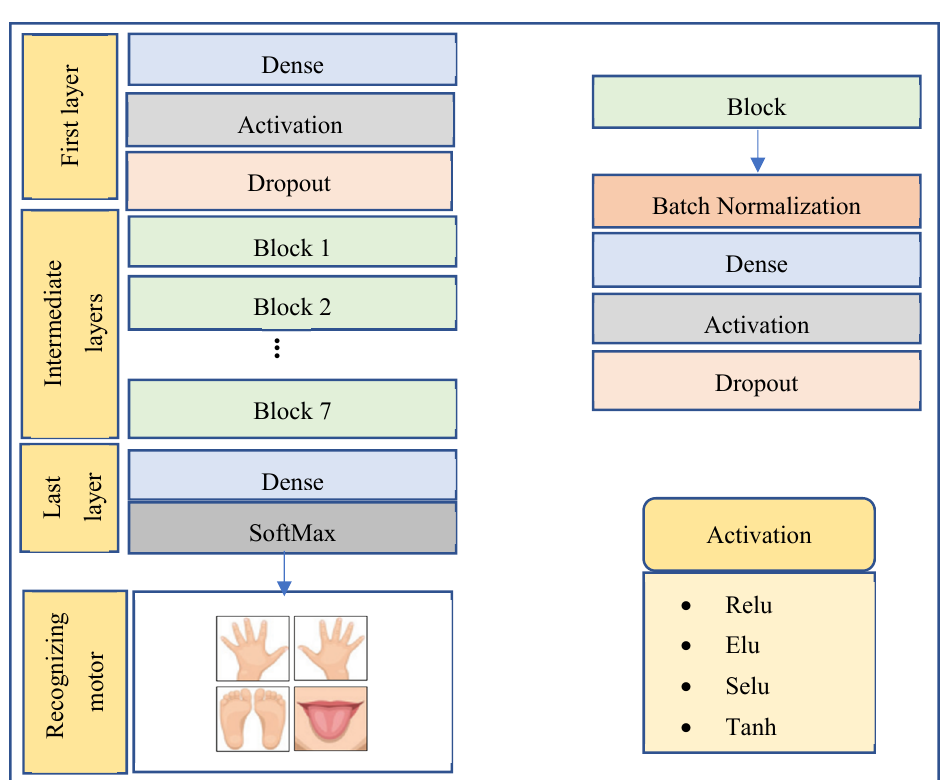
Figure 6. The proposed ANN model.